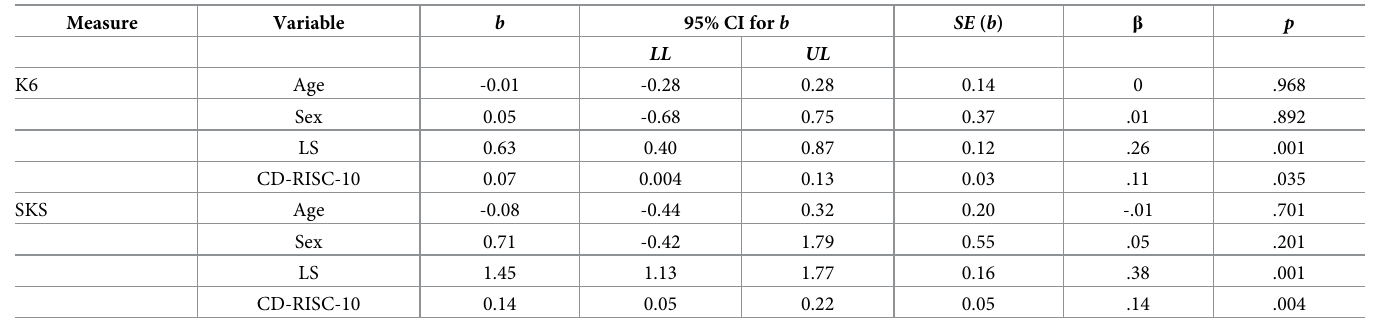
Table 6. Multiple regression analysis results explaining K6 and SKS with CD-RISC-10 and control variables.